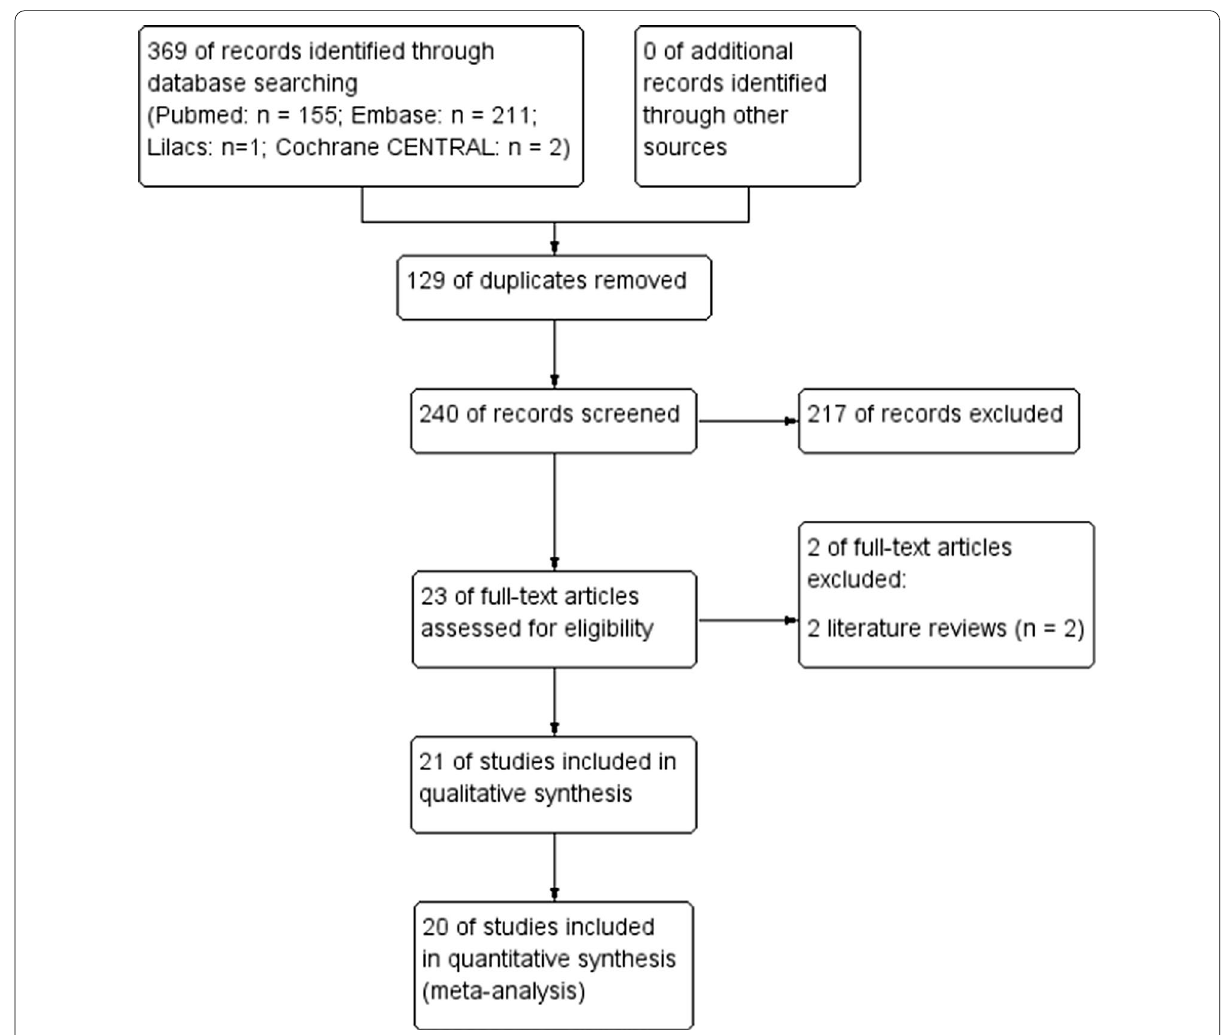
Fig. 1 Study flow